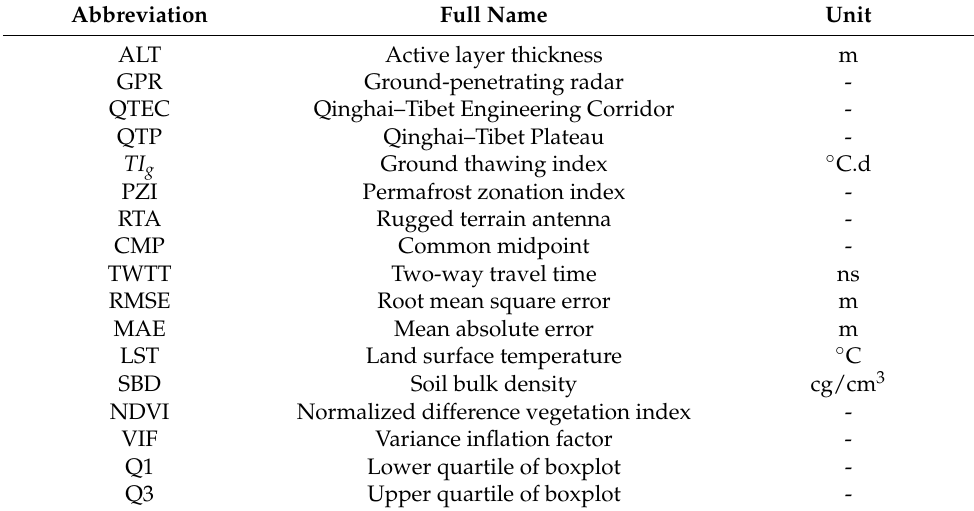
Table A1. The table of abbreviations. Abbreviations and units used in this